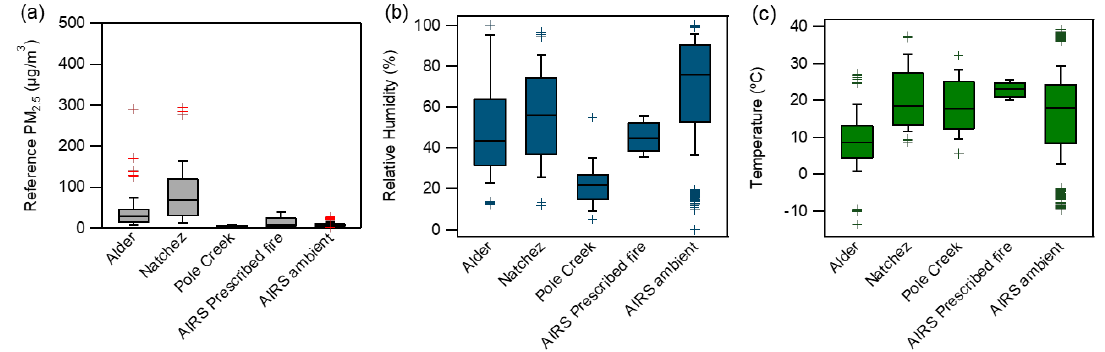
Figure 1. Box plots for ( a ) reference PM 2.5 hourly concentrations ( b ) RH and ( c ) temperature at each fire from the reference monitor. Whiskers denote the 10th and 90th percentiles, symbols represent data outside of 1.5 times the interquartile range. Natchez RH and temperature estimated from corrected PA and AQY measurements.